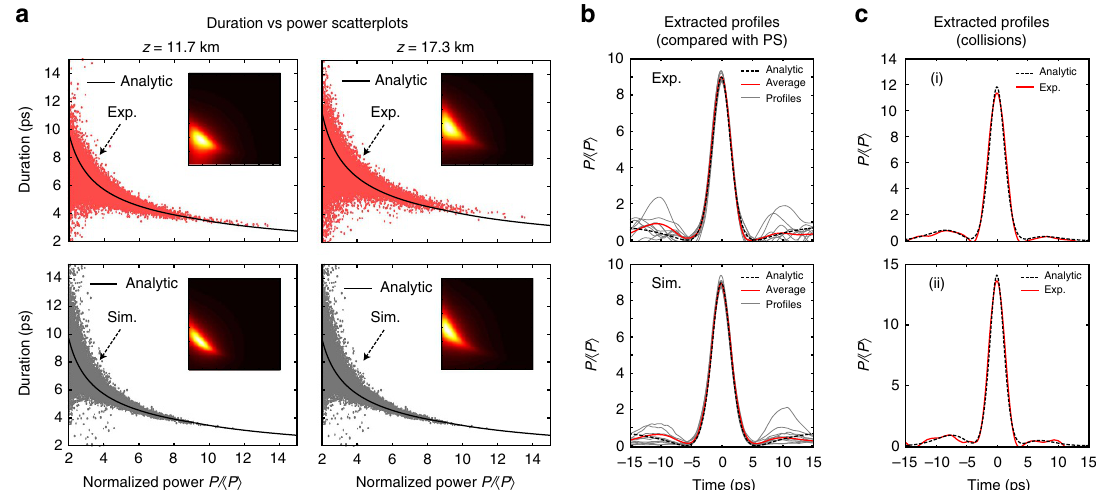
Figure 4 | Temporal properties of breathers. ( a ) Scatter plots of pulse duration against normalized power from experimental intensity profiles (top, red points) and simulation profiles (bottom, grey points) for 11.7 and 17.3km propagation respectively, compared with theory (black line) in each case. The insets show the scatter plot converted to a false-color density map. ( b ) Results extracting 10 intensity profiles at 11.7km with P = h P i (cid:4) 9 (grey lines) from experiment (top) and simulation (bottom). The average intensity profiles (red lines) are compared with the analytic PS (black dashed lines), showing excellent agreement over the central peak. ( c ) Two peaks of higher intensity (grey lines) with (i) P = h P i (cid:4) 11 : 5 and (ii) P = h P i (cid:4) 13 : 5. The dashed line in each case shows a higher-order breather (bottom, grey points) at two propagation distances as shown. As